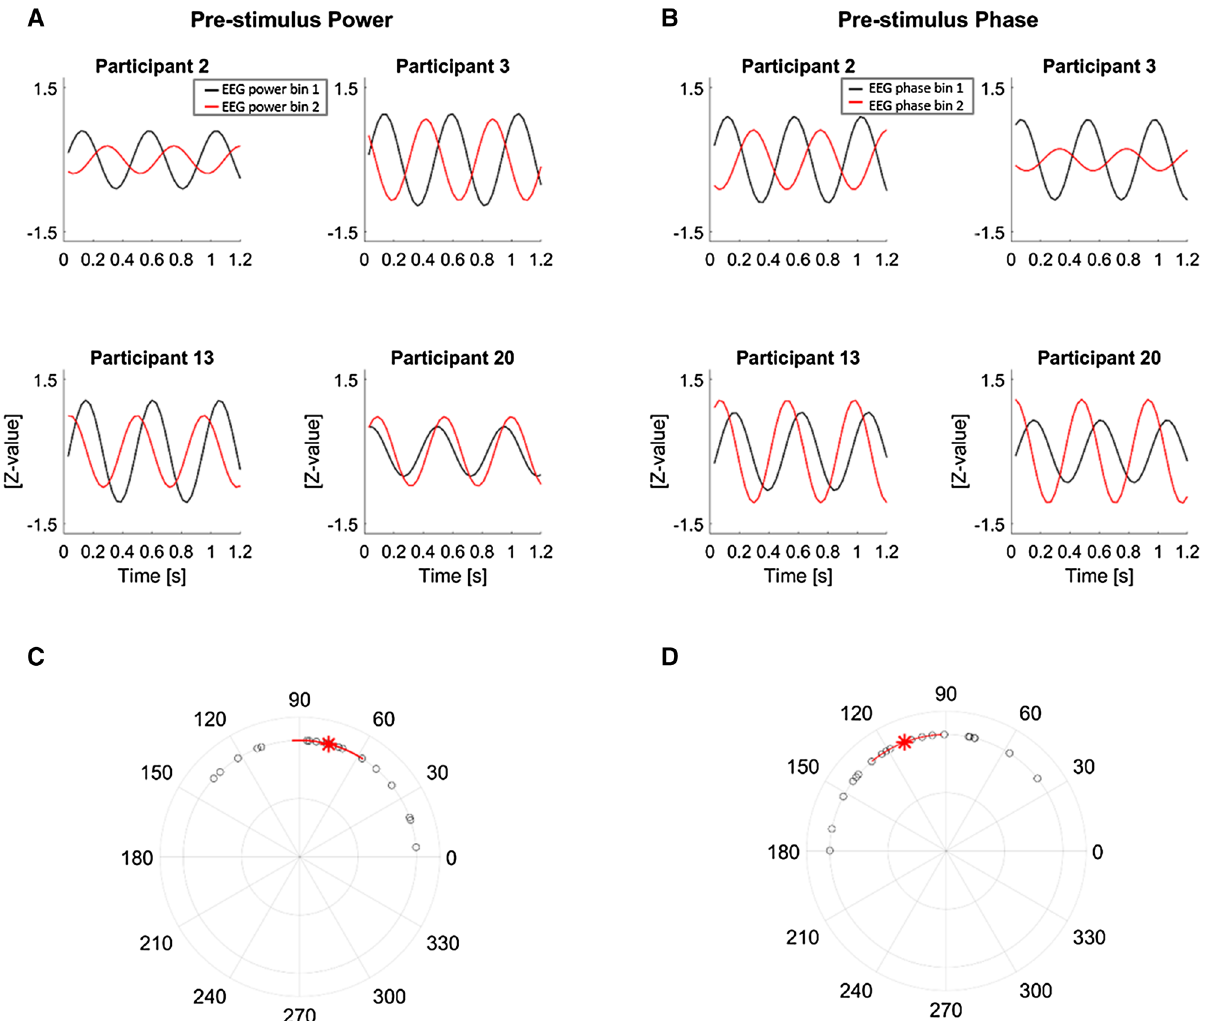
Figure 5. Visualization of the change in rhythmic perceptual sampling with EEG power and phase. ( A , B ) Examples of the rhythmic components (at 2.2 Hz perceptual sampling frequency) of the perceptual weights for four participants reconstructed using the respective participant’s specific bins for EEG power ( A ) and phase ( B ). For this analysis we considered the EEG power and phase bins at 4 Hz for each participant yielding the largest difference, derived at EEG electrode Pz for power and FC2 for phase. ( C , D ) Absolute phase differences in the rhythmic component of the perceptual weights between the EEG power ( C ) and phase ( D ) bins for each participant. The group-mean is marked with the red star and 95% confidence intervals (CI) are marked by the red